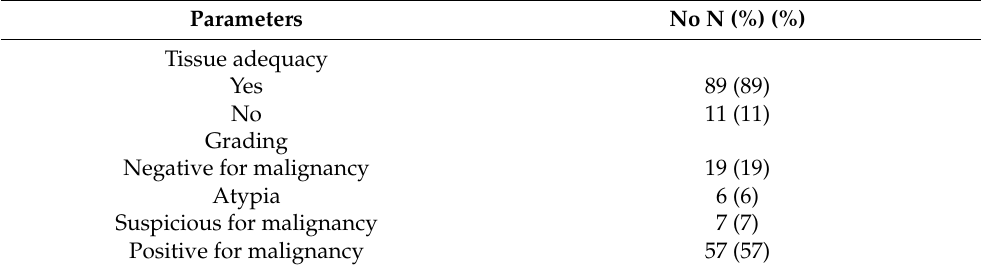
Table 3. Histological assessment of sampling specimens from EUS-FNB. Parameters